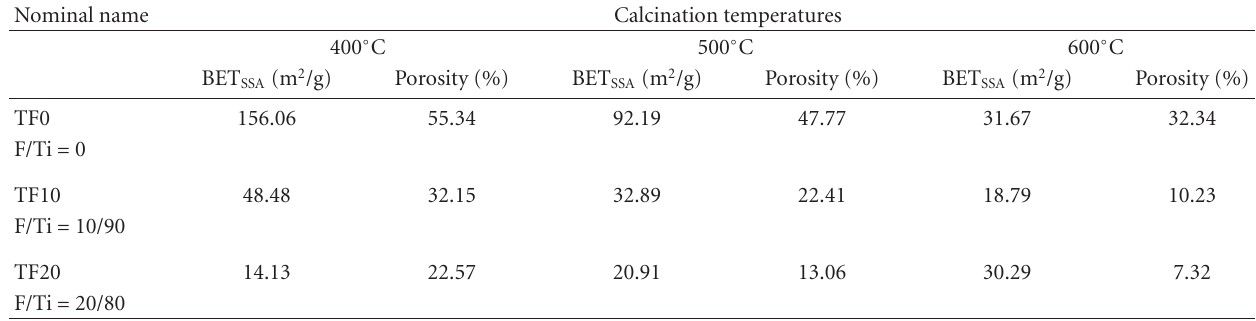
Table 2: BET surface area and porosity of TiO 2 powders calcinated at di ff erent